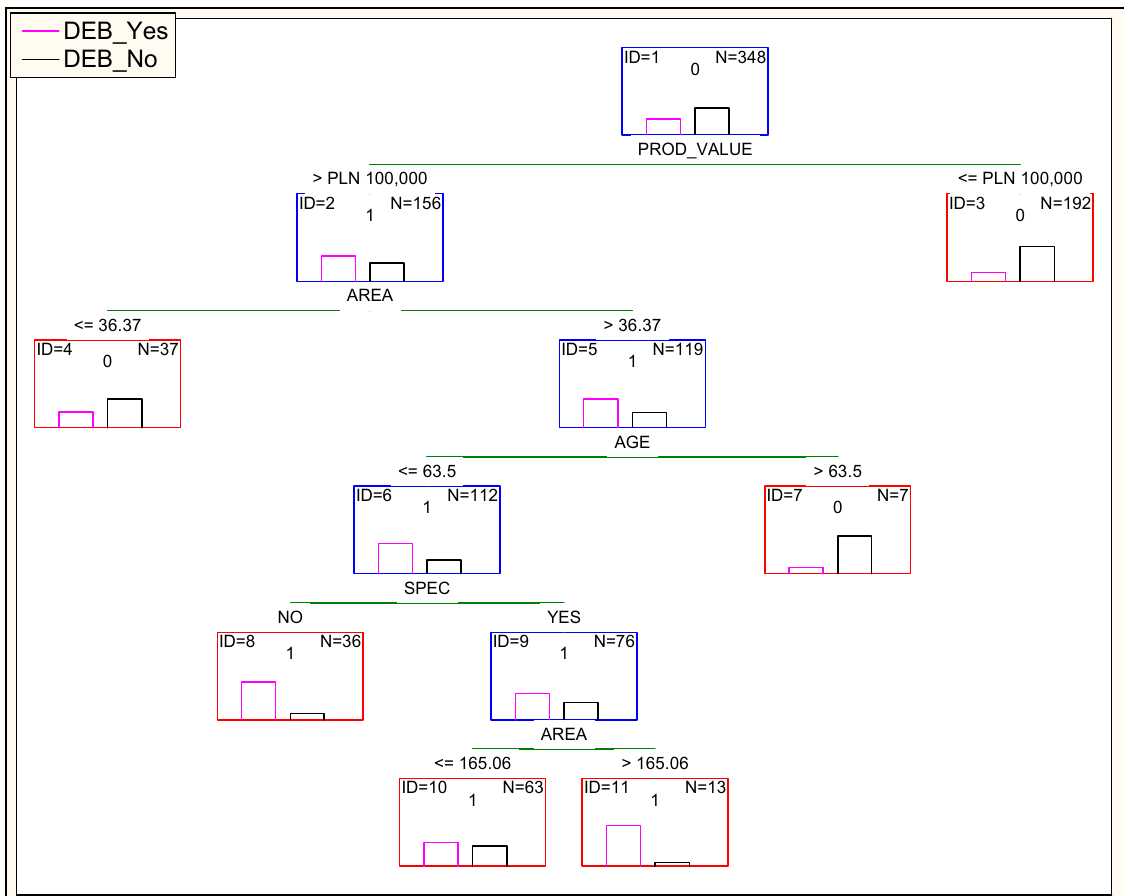
Figure 2. Classification and regression tree (CRT). Source: Own study.